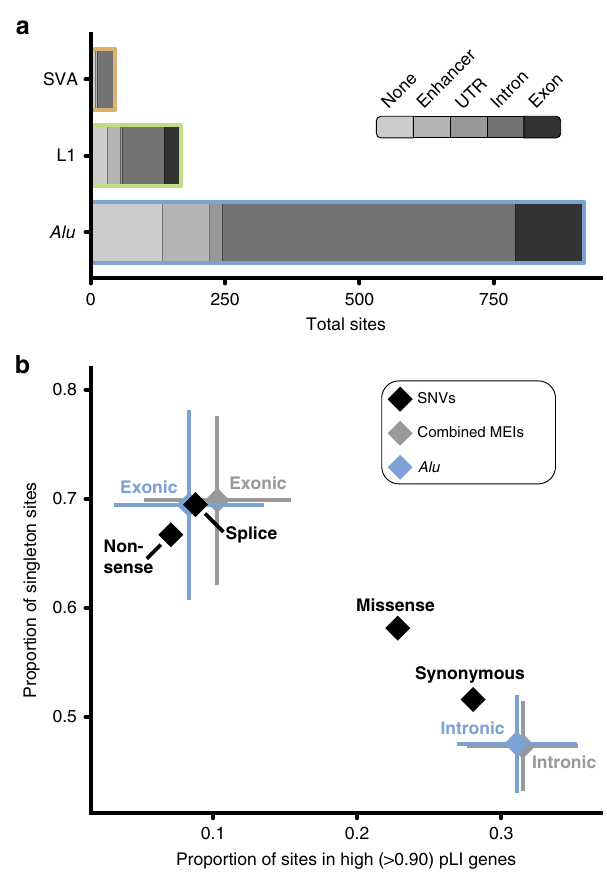
Fig. 2 Coding constraint on MEIs. a Cumulative consequence annotations for Alu , L1, and SVA MEIs in all samples ( n = 28,132 individuals) analyzed. The majority of variants identi fi ed in this study fell within the noncoding space (either an enhancer or intron). b Comparison of constraint between MEIs and SNVs in unaffected parents. To compare the impact of exonic and intronic Alu (blue) and all MEIs (grey) to varying classes of SNVs (black), we used two metrics: the proportion of variants in genes that have been identi fi ed as LoF intolerant as gauged by pLI-score 22 ( x -axis) and the proportion of variants identi fi ed in only one individual (i.e., singletons; y - axis). Error bars indicate 95% con fi dence intervals based on population proportion; con fi dence intervals were calculated for SNVs, but are too small to appear at the resolution displayed in this fi